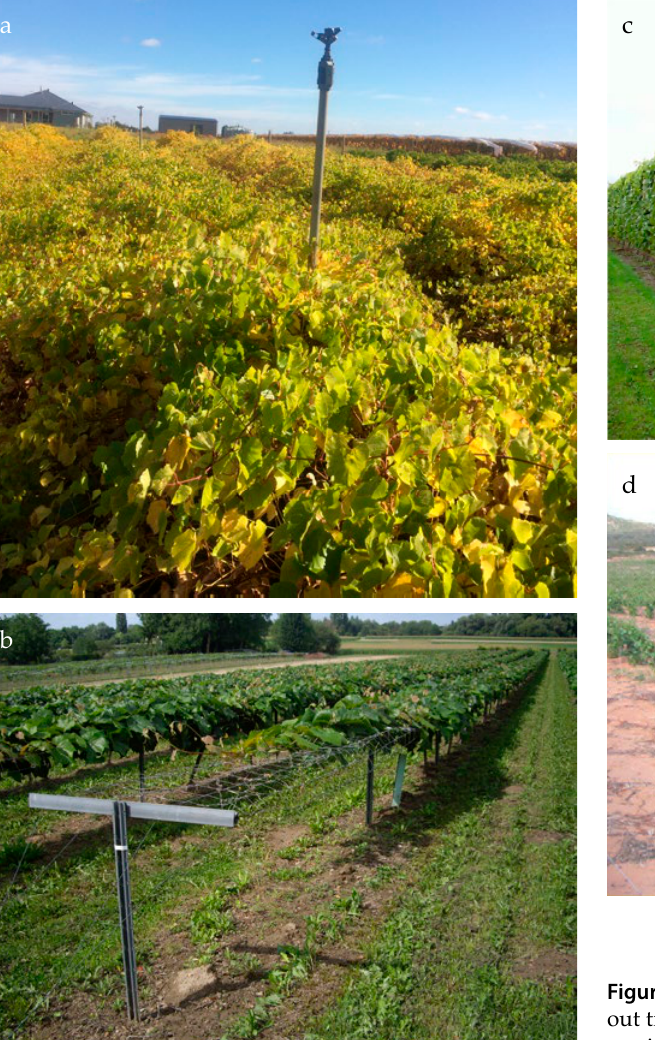
Figure 1. a) Standard rootstock mother vine planting with- out trellis, and three alternative types of rootstock trellis; b) vertical, c) horizontal, and d)